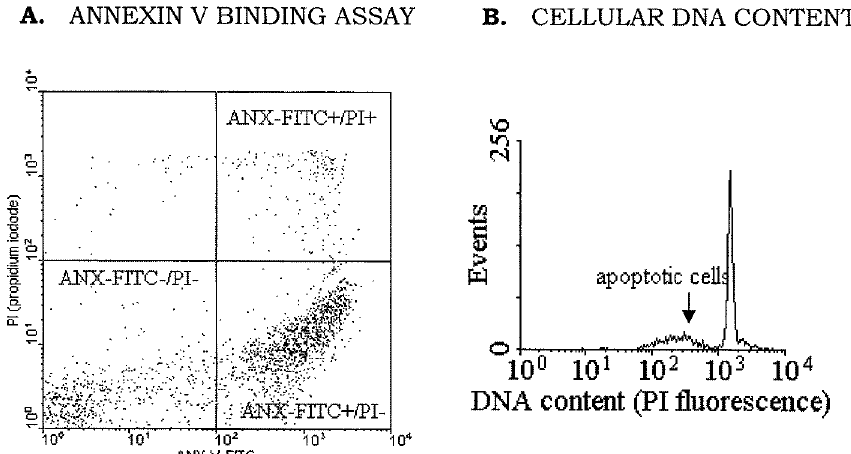
FIG. 1. An example of the quantitation of apoptosis using flow cytometry. (A) Typical dot plot diagram of ANX-FITC/PI flow cytometry of cells undergoing apoptosis. The lower left quadrant shows the viable cells, which exclude PI and are negatives for ANX-FITC binding. The lower right quadrant represents the early apoptotic cells, ANX-FITC positive and PI negative, demonstrating cytoplasmic membrane integrity. The upper right quadrant contains the non-viable, necrotic or late apoptotic cells, positive for ANX-FITC binding and for PI uptake. The data are presented as the sum of percentage of cells located in the lower right and the upper right quadrants. (B) Histogram of cells analyzed for PI fluorescence (DNA content). The histogram shows the appearance of the apoptotic region (indicated by arrow) for cells undergoing